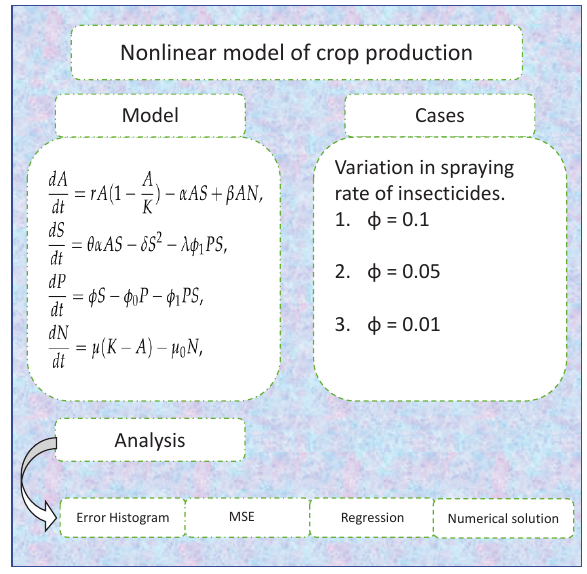
Figure 3. Nonlinear model of crop production and its different cases. The numerical technique gives data set values that can be used to train, validate, and test data with 80%, 10%, and 10% probability. Each example’s mean square error (MSE) function convergence is shown graphically. Figure 4 shows the performance values for the case 1 which are in the range of 7.68 × 10 − 8 , 1.48 × 10 − 6 , 1.94 × 10 − 11 and 3.48 × 10 − 8 . Similarly Figures 5 and 6 illustrate the performance values for case 2 and 3 respectively, which are in the range of 2.79 × 10 − 7 , 1.48 × 10 − 6 , 1.94 × 10 − 11 , 7.07 × 10 − 8 , 4.38 × 10 − 7 , 2.98 × 10 − 8 , 4.31 × 10 − 11 and 3.52 × 10 − 8 .